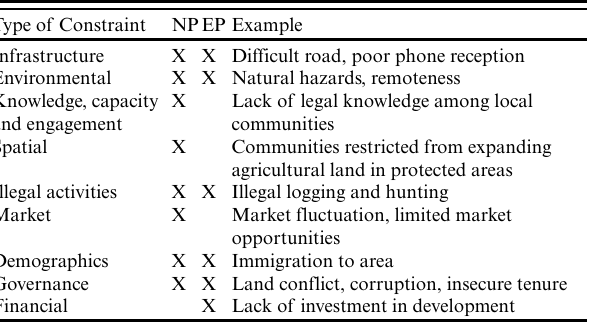
Table 2. Constraints preventing landscape from functioning as well as it could according to respondents